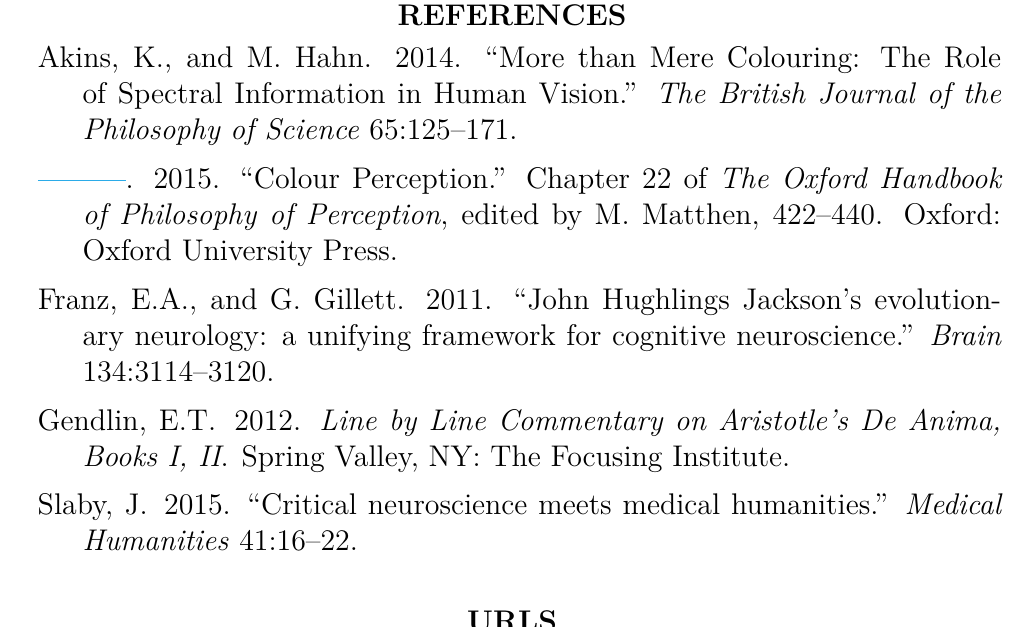
light embody both dependent and inde- pendent sources of information about the distal world.’ Akins and Hahn 2014,